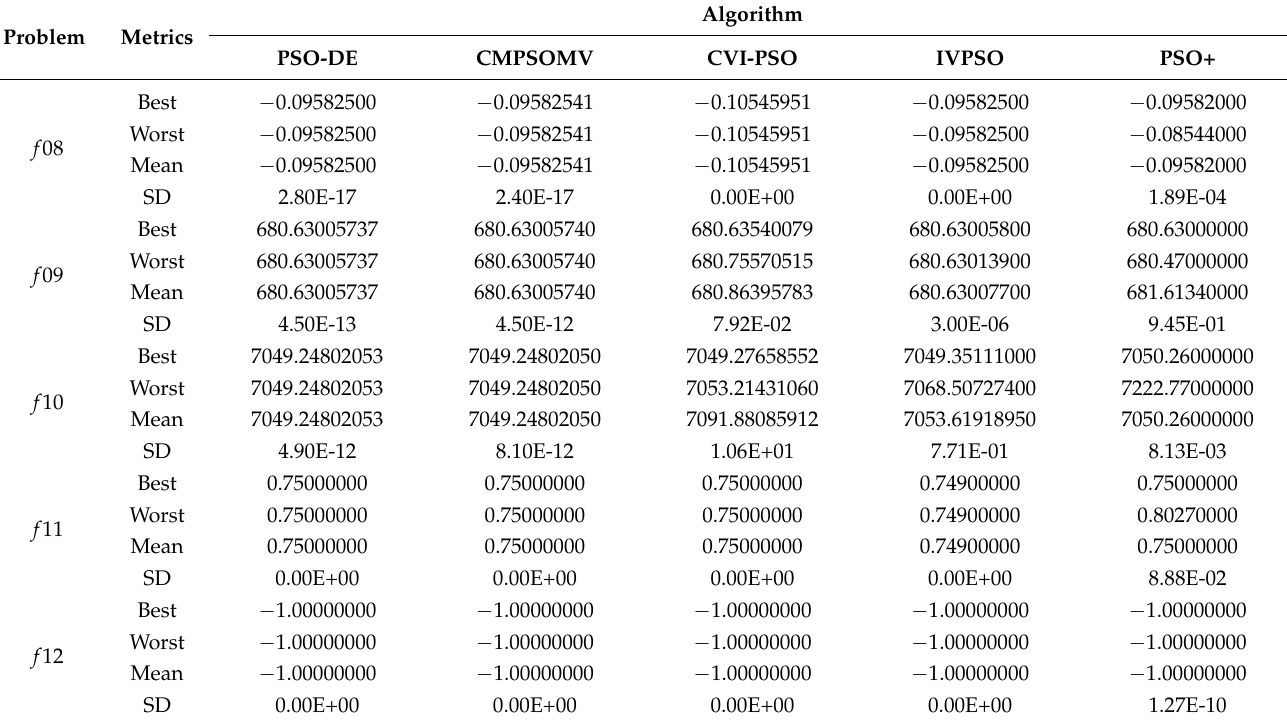
Table 4. The results of PSO-DE compared with PSO variant algorithms in benchmark